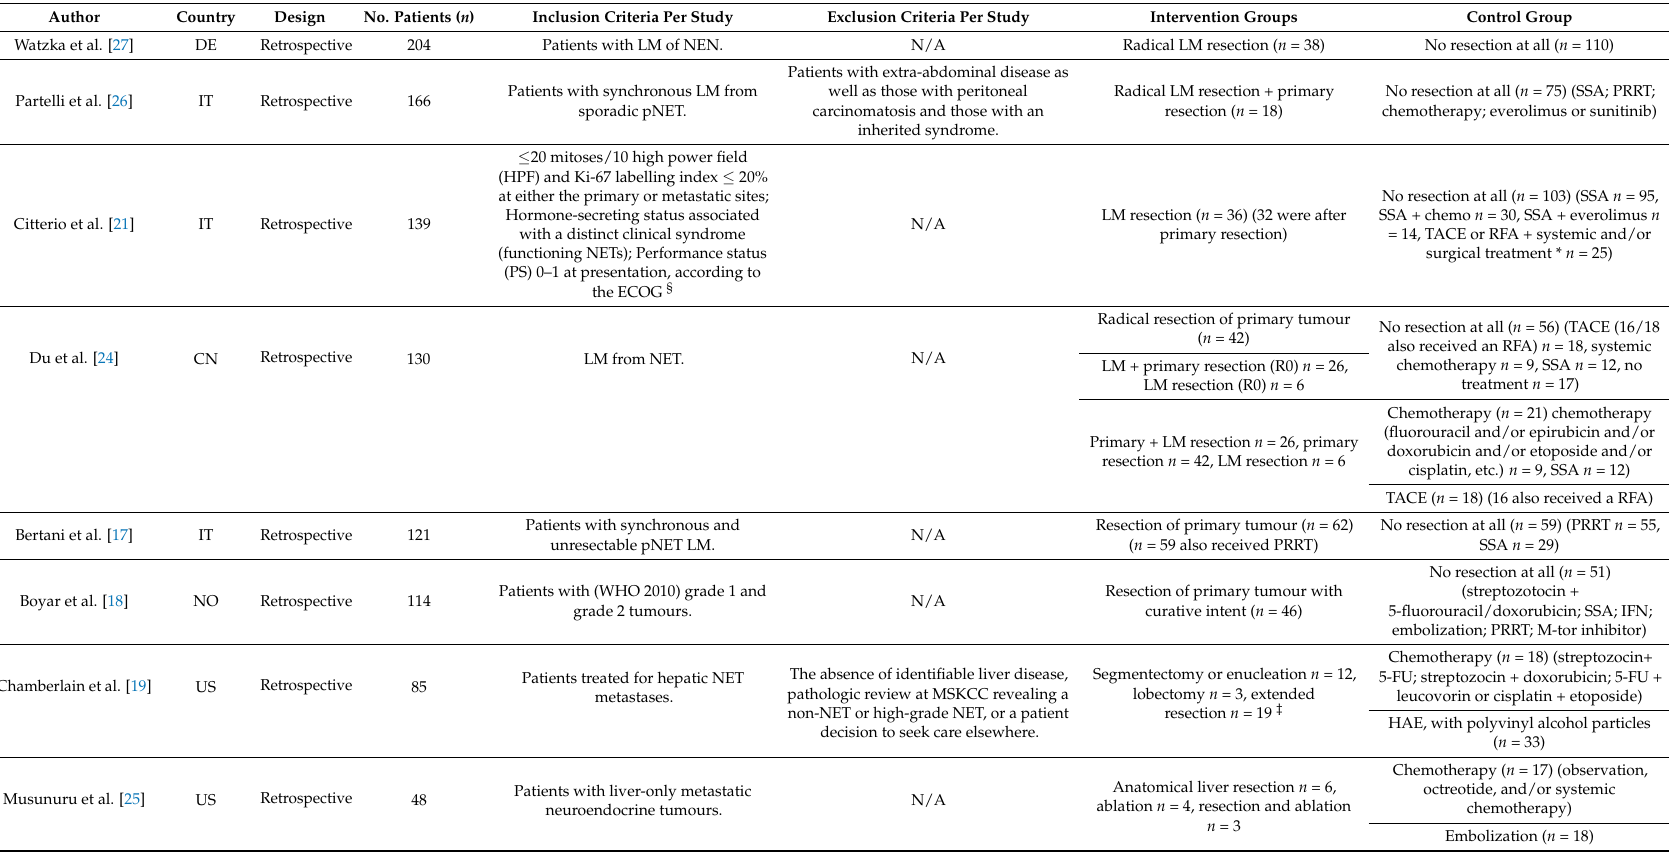
Table 1. Characteristics of included